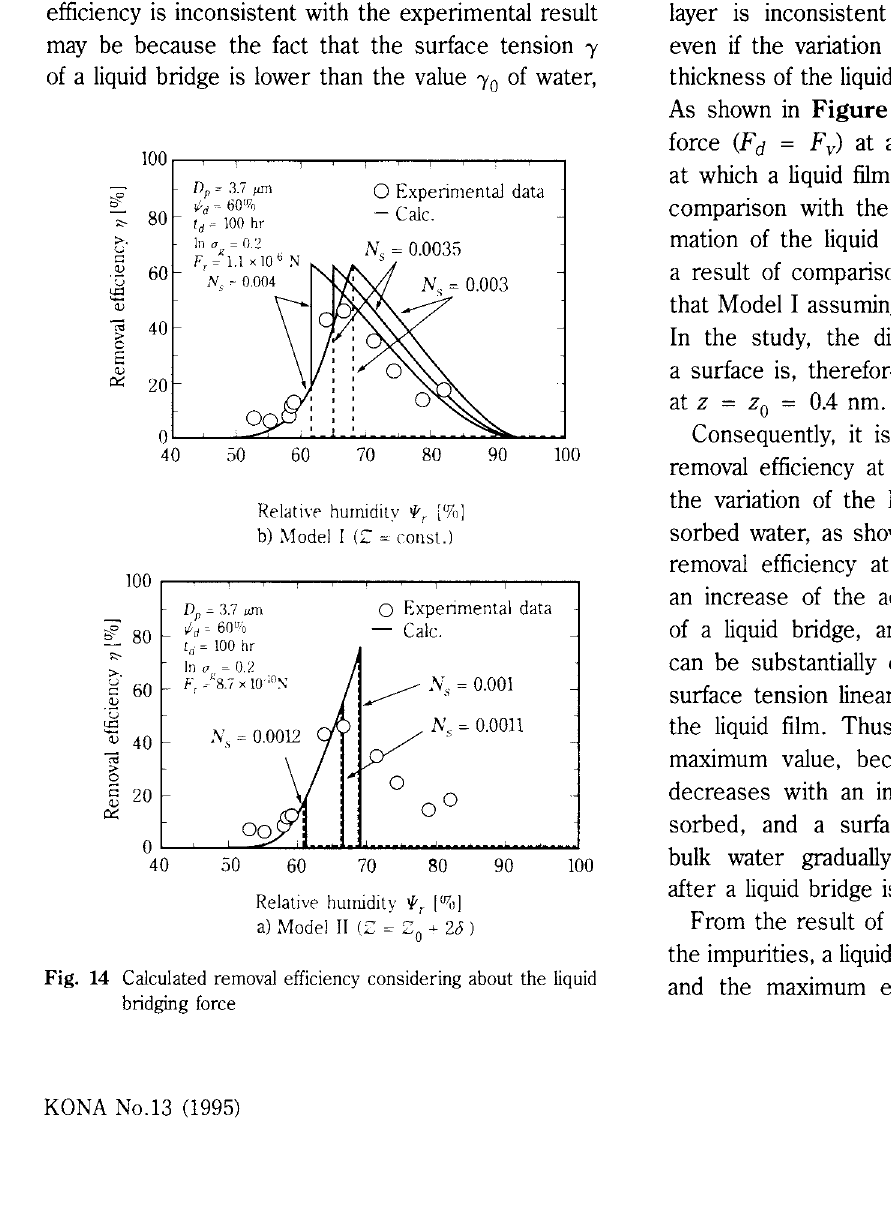
Fig. 14 Calculated removal efficiency considering about the liquid bridging force